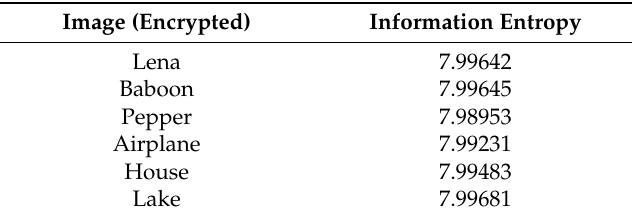
Table 6. Global information entropy of encrypted images.